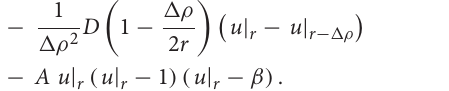
FIGURE 9 | Temporal dynamics of the value of u at the junction point between the flat boundary and the corner of a rectangularly shaped FPR. An increase of D , A , or R inside the FPR delays the time t p when the excitation threshold is